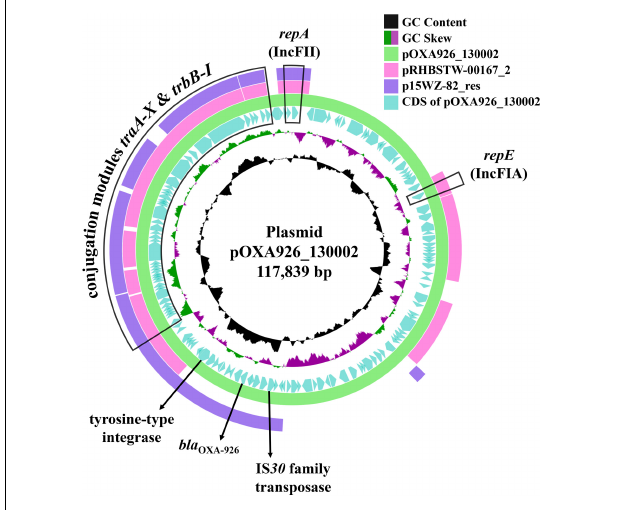
FIGURE 4 | Alignment of pOXA926_130002 with RHBSTW-00167_2 and p15WZ-82_res. pOXA926_130002 is a 117.8-kb IncF plasmid and has bla OXA − 926 . Plasmid replication initiation-encoding genes repA of the IncFII replicon and repE of the IncFIA replicon and the conjugation module containing multiple genes ( traA to traX and trbB to trbI ) are indicated. A gene encoding the transpose of an IS 30 family insertion sequence at upstream of bla OXA − 926 and a gene encoding a tyrosine recombinase-like integrase at downstream are also shown. pOXA926_130002 is the closest (56% coverage and 97.1% identity) to pRHBSTW-00167_2 (accession no. CP058119), a 223.8-kb K4:A10:B- type IncF plasmid with an additional IncR replicon of an K. michiganensis strain recovered in United Kingdom in 2017. pRHBSTW-00167_2 has no bla OXA − 926 , while p15WZ-82_res (accession no. CP032357) is another bla OXA − 926 -carrying plasmid of a K. variicola clinical strain recovered from an unspecified place in China in 2015. p15WZ-82_res belongs to the K4:A-:B- IncF type and also contains a K (pCAV1099-114 type) IncFIB allele. pOXA926_130002 had a 53% coverage and 99.0% identity with p15WZ-82_res.